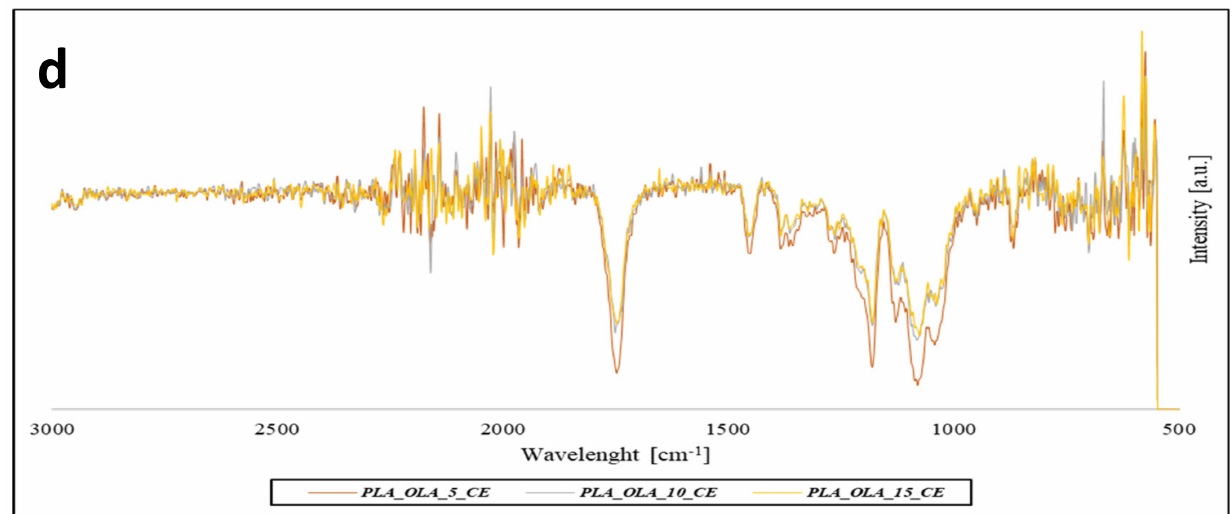
Figure 9. ATR-FTIR spectra of PLA_PEG-EX ( a), PLA_OLA_EX ( b), PLA_PEG_CE ( c ), and PLA_OLA_CE ( d ) formulations with different amounts of plasticizers.